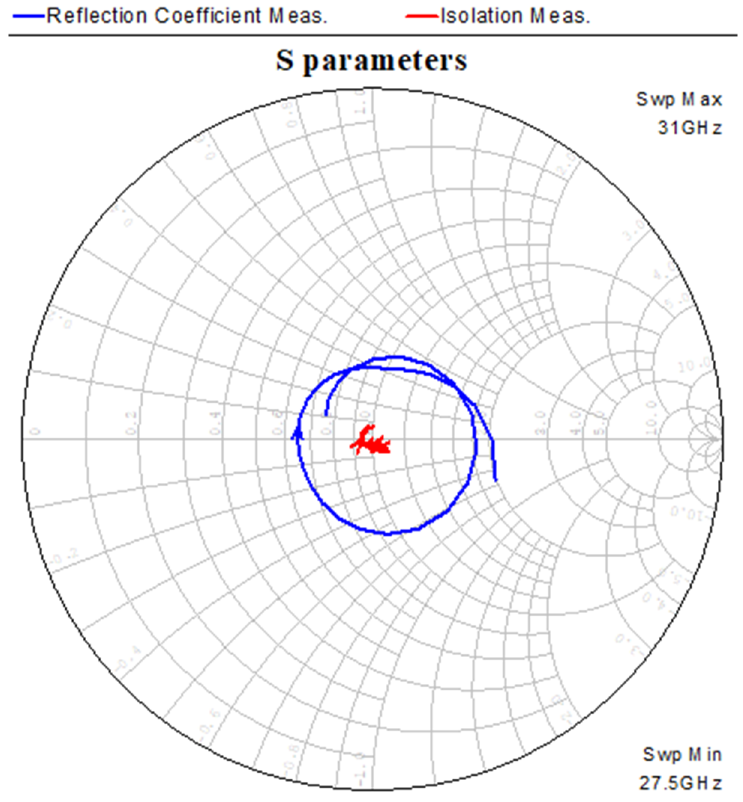
Figure 6. Smith chart of the return loss and isolation results for a single radiating element in the Ka band frequencies from 27.5 to 31 GHz.